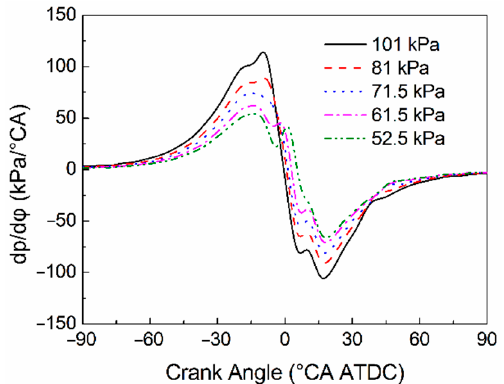
Figure 6. Pressure rise rate under the various MAPs.